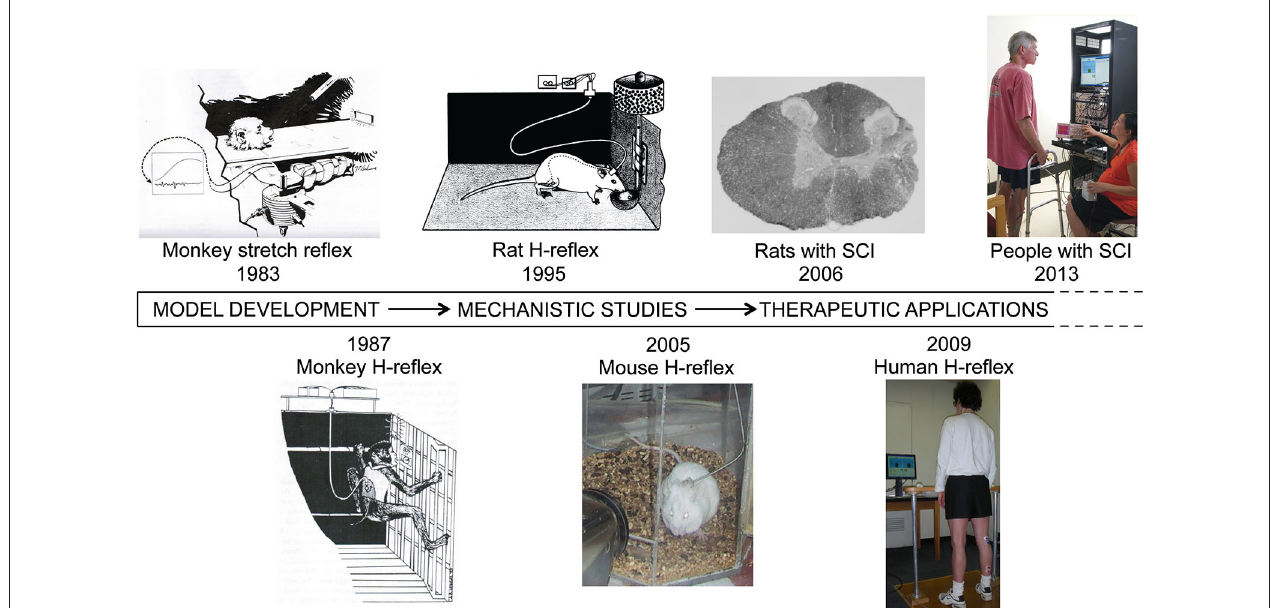
FIGURE 1 | Operant conditioning of spinal reflexes from 1978 to 2013. The work began with model development and progressed to mechanistic studies and then to clinical applications. These three phases have